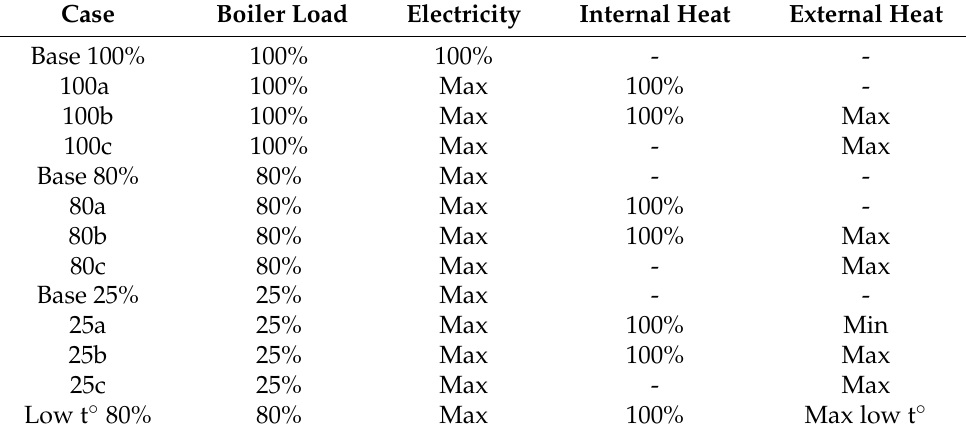
Table 5. Simulated